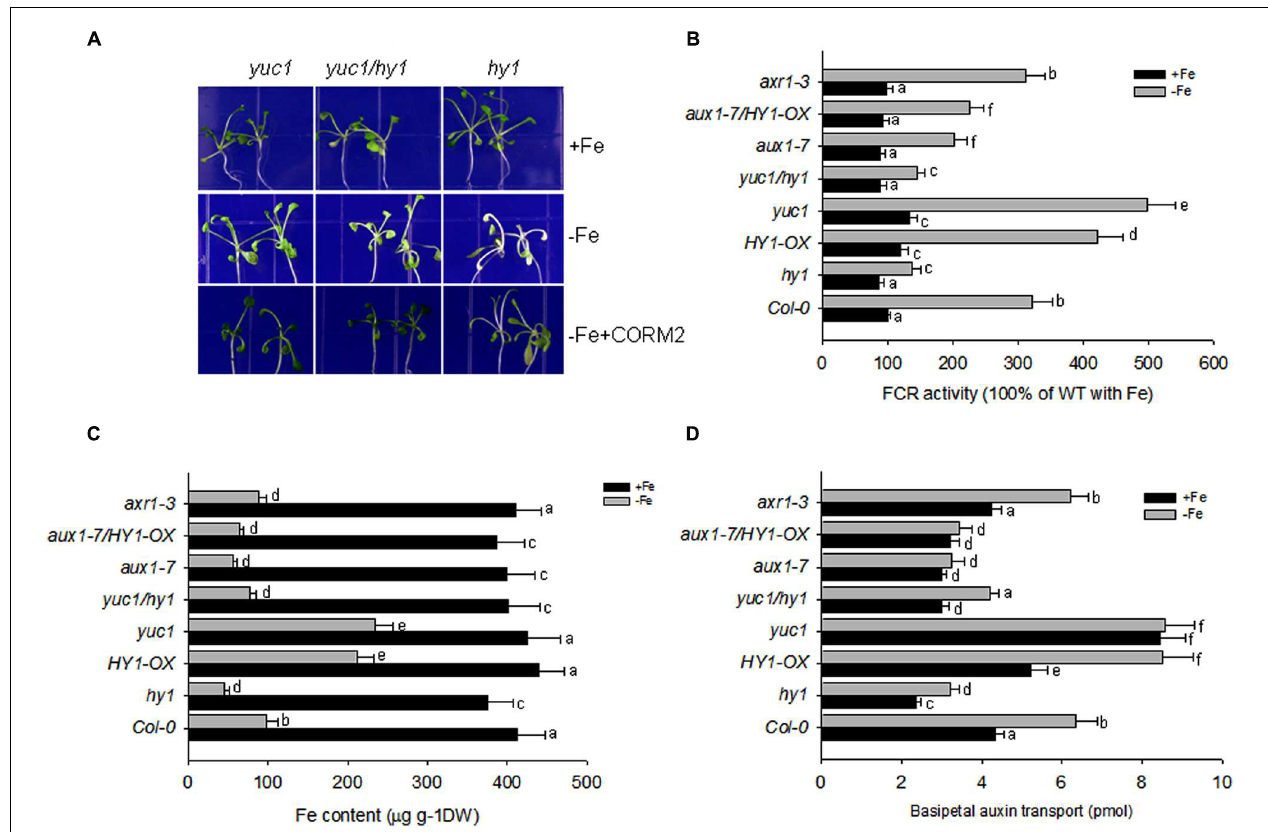
FIGURE 5 | Auxin and CO modulate the response to –Fe in Arabidopsis . (A) The phenotypes of yuc1 , yuc1/hy1, and hy1 seedlings grown on + Fe, –Fe, or –Fe + CORM2 media for 1 week. These lines were all first grown on + Fe media for 2 weeks. Lines kept on + Fe media were used as the positive control. (B–D) The effect of –Fe stress on FCR activity (B) , Fe content (C) , and basipetal auxin transport (D) in the wild-type Col-0, hy1, and HY1-OX lines. All lines were first grown on + Fe media for 2 weeks and then shifted to –Fe media (–Fe) or kept on + Fe media ( + Fe) for 1 week before measurements were taken. Data are the means ± SD ( n = 10), and bars with different letters are significantly different at p < 0.05 (Tukey’s